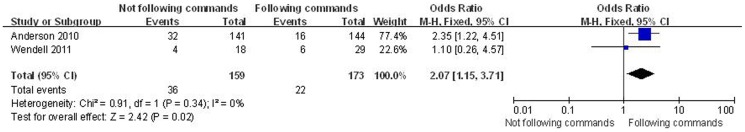
Meta-analysis result of following commands.